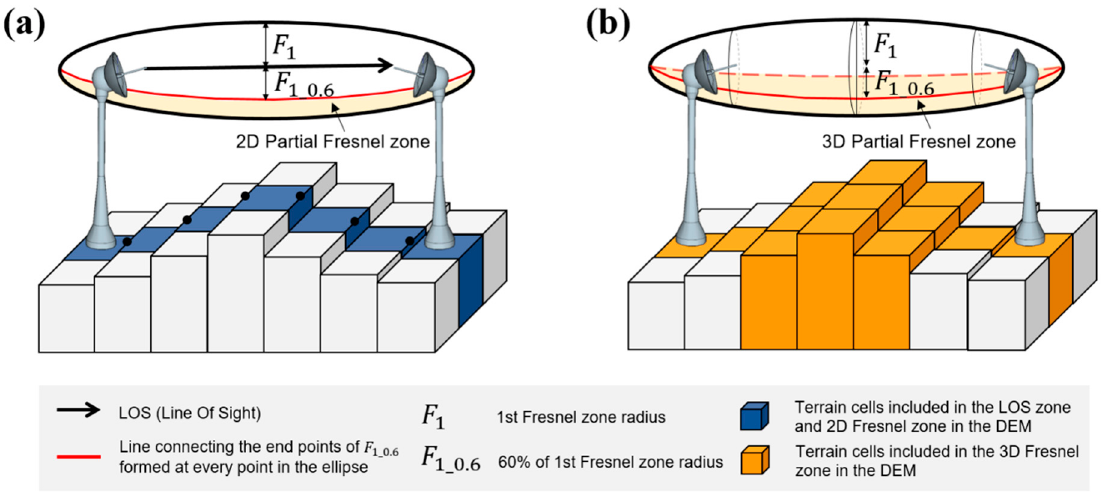
Figure 1. Conceptual view showing the process for estimating signal coverage using ( a ) LOS analysis and 2D Fresnel zone analysis; and ( b ) 3D Fresnel zone